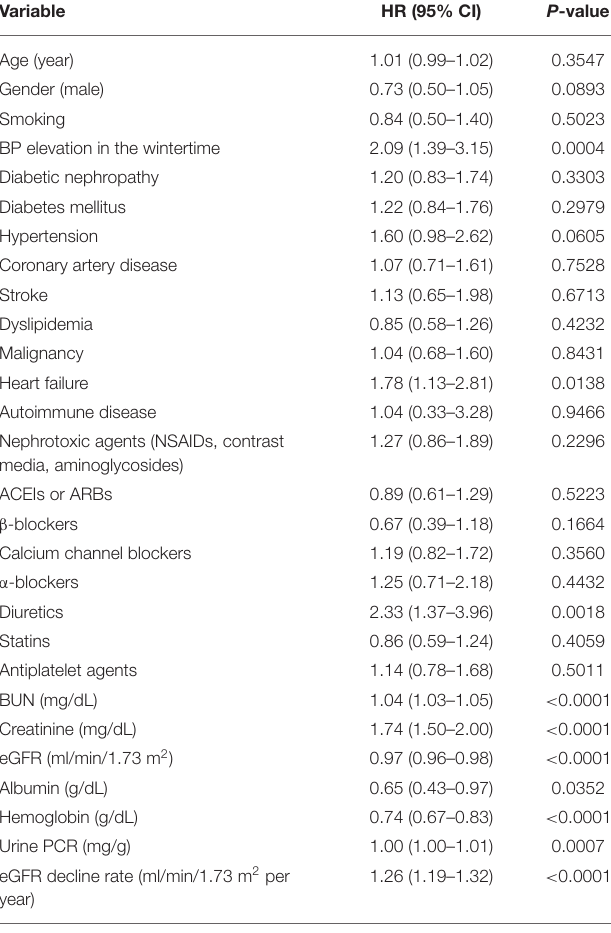
TABLE 6 | Cox regression analysis for association between clinical factors and poor outcome (eGFR decline ≥ 40%, dialysis, transplantation, or death) in 288 CKD patients with home BP monitoring.